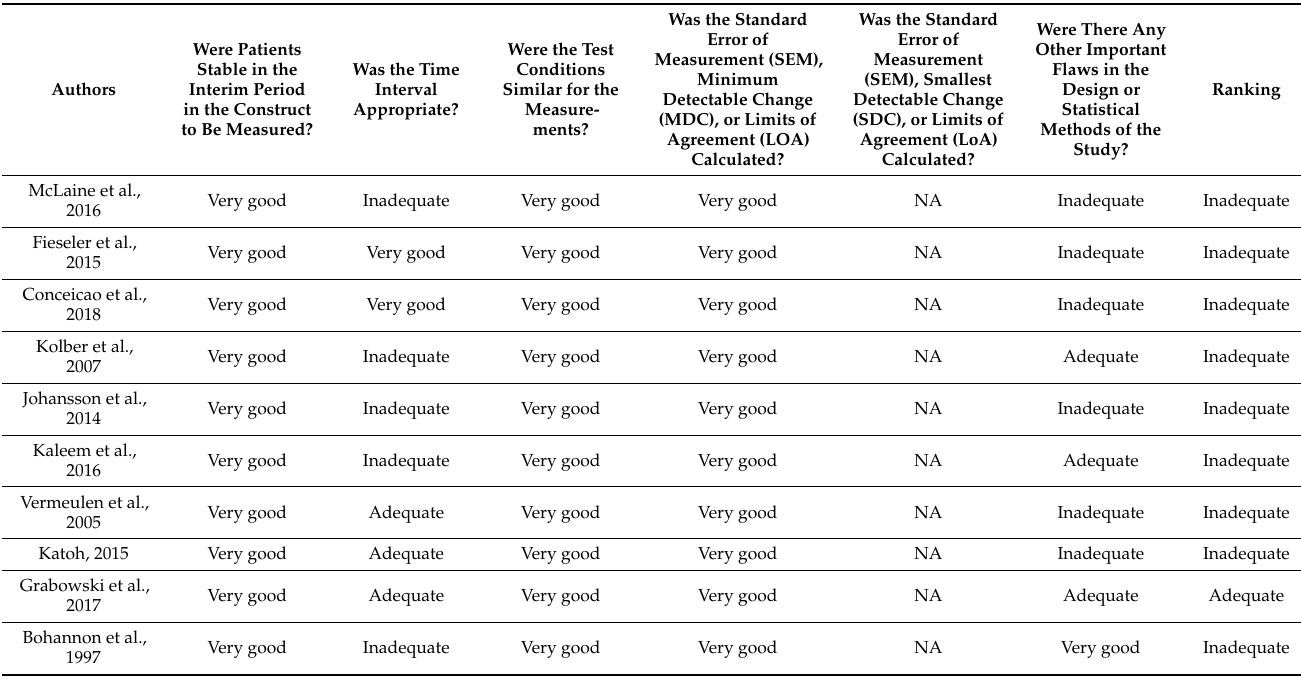
Table 5. Methodological quality considering the COSMIN checklist for studies included in absolute reliability of HHD (box 7).